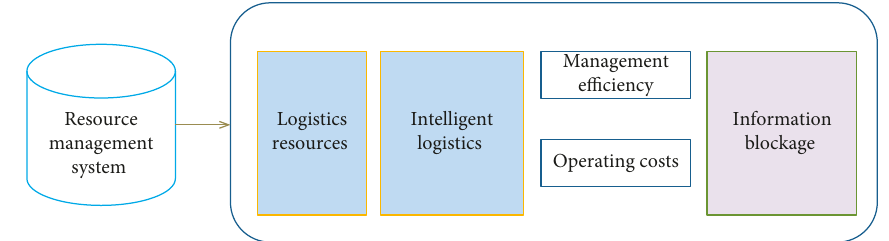
Figure 1: Frame diagram of the resource management system.